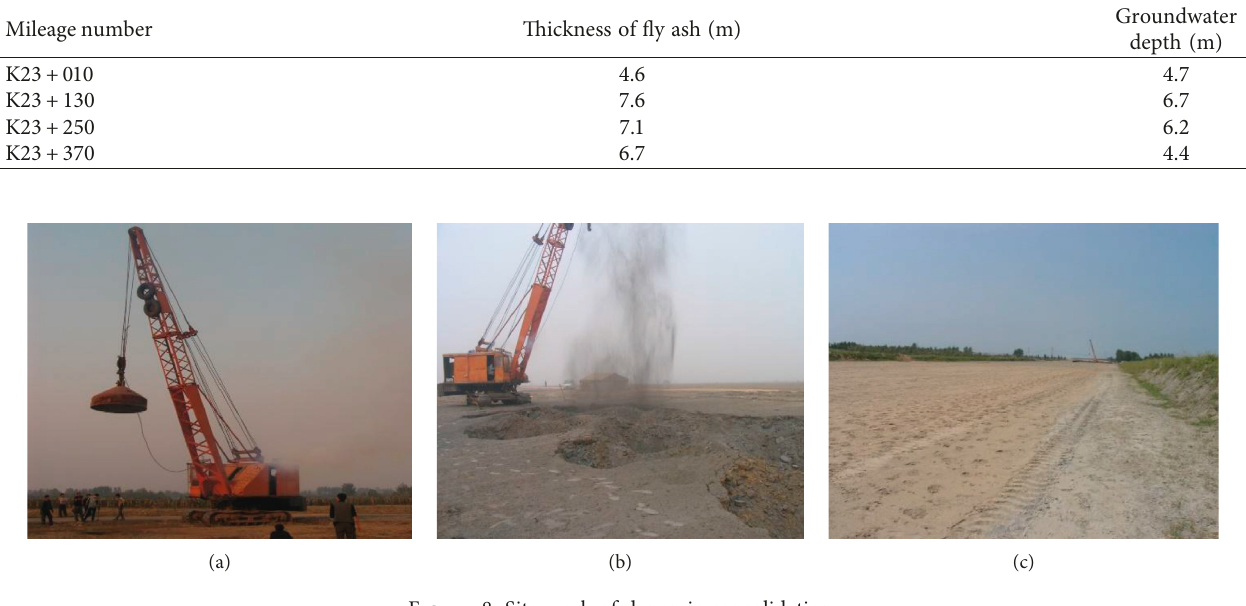
Figure 8: Site work of dynamic consolidation.